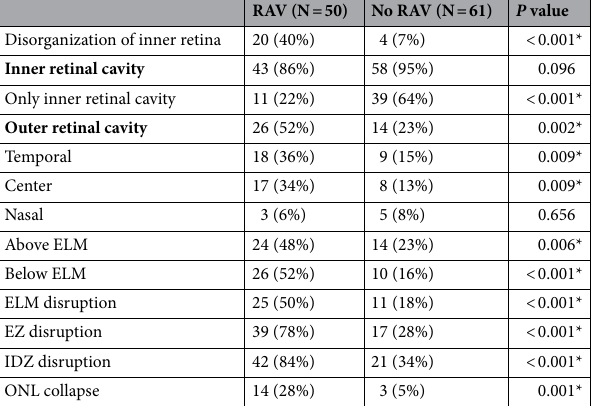
Table 2. SD-OCT findings of included eyes according to the presence of right-angled vessel. ELM external limiting membrane, EZ ellipsoid zone, IDZ interdigitation zone, ONL outer nuclear layer, RAV right-angled vessel. * P values < 0.05 by chi-square test or Fisher’s exact